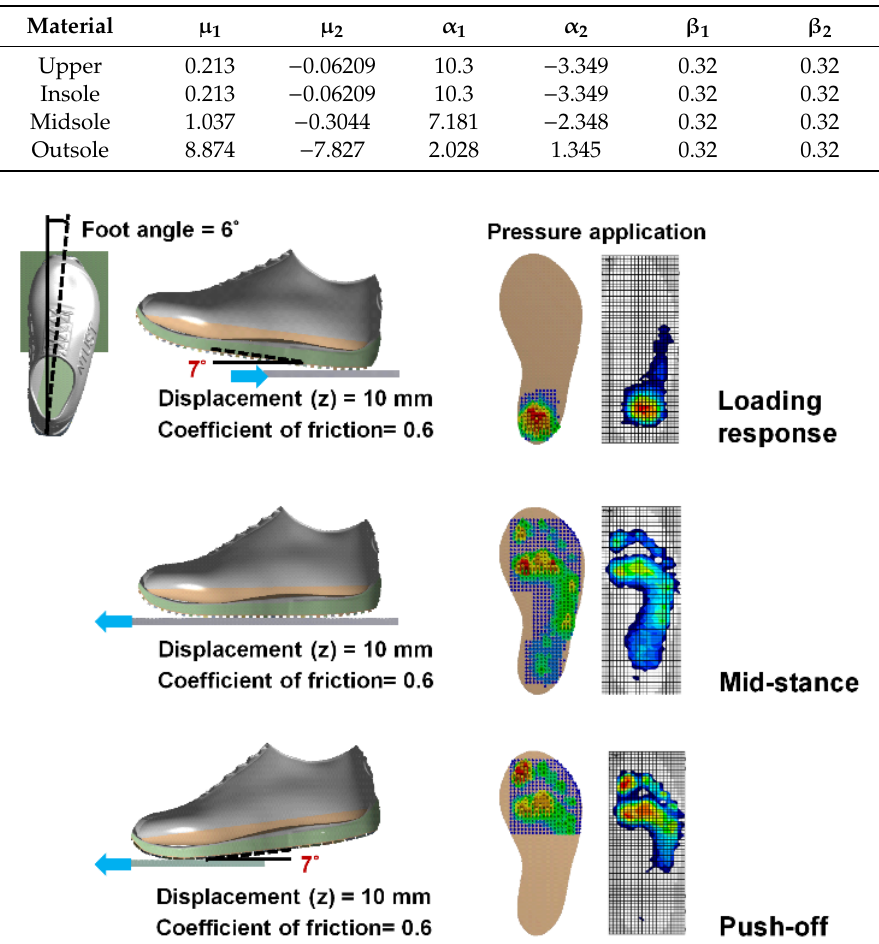
Figure 4. The position, boundary, and loading conditions of the finite element (FE) analysis three major phases of a gait cycle.